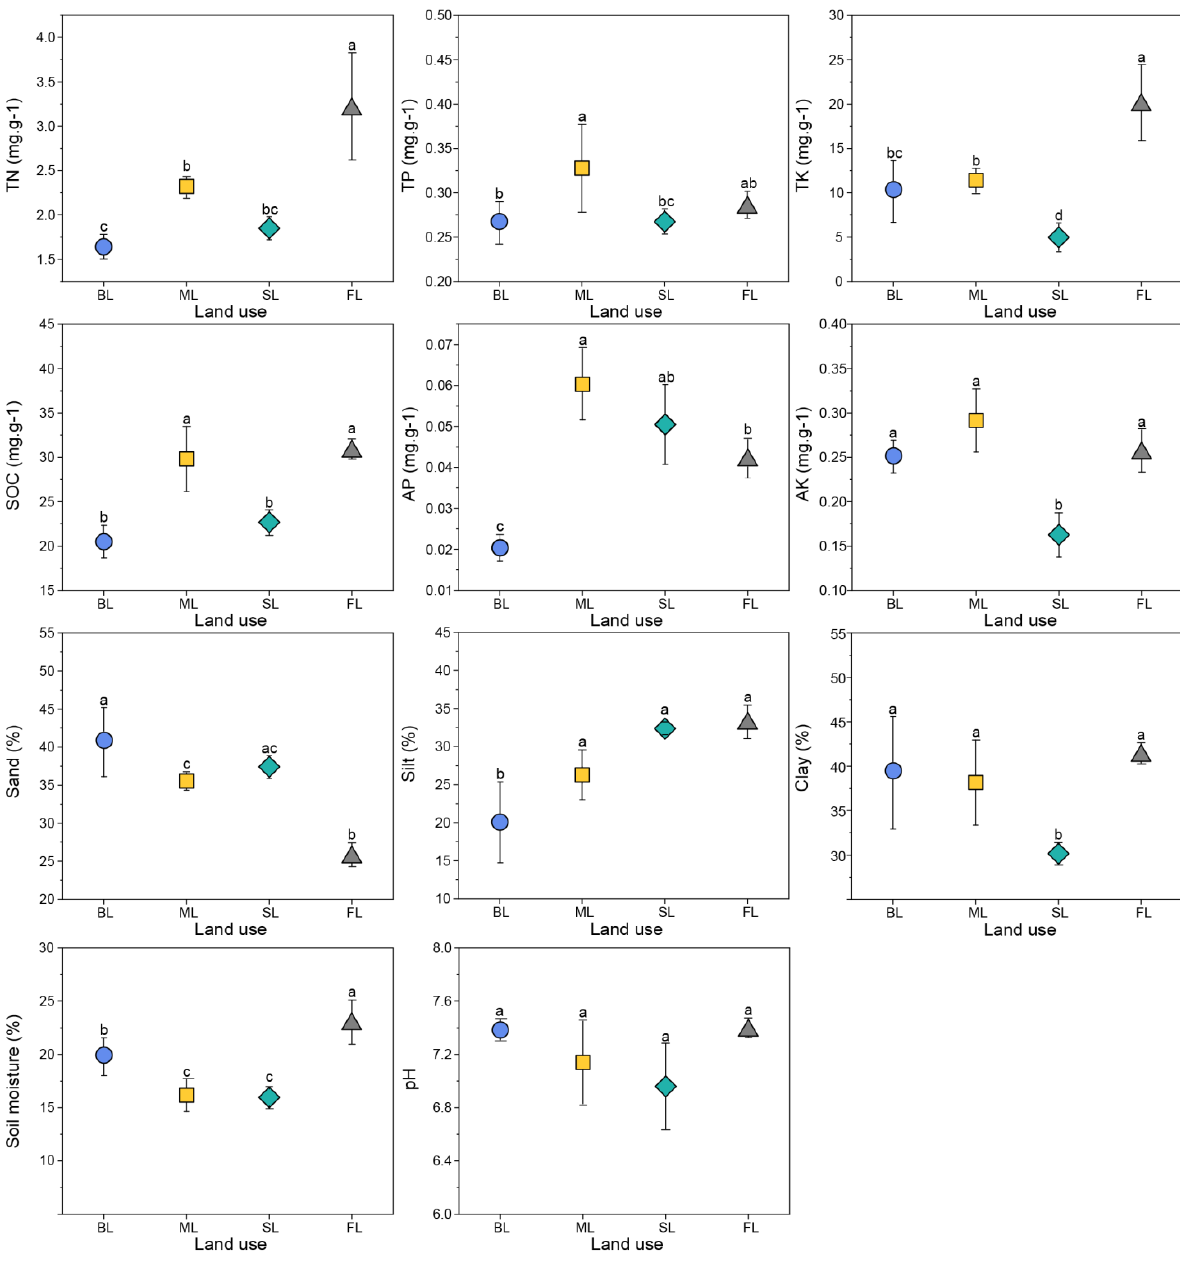
Figure 2. Soil physicochemical properties in four land-use types. Different letters denote significant differences ( p < 0.05) between treatments as determined by quartic comparisons with Fisher’s least significant difference (LSD). Abbreviations: FL, forest land; SL, sugarcane land; ML, maize land; BL, barren land; TN, soil total nitrogen; TP, soil total phosphorus; TK, soil total potassium; SOC, soil organic carbon; AK, available potassium; AP, available phosphorus.